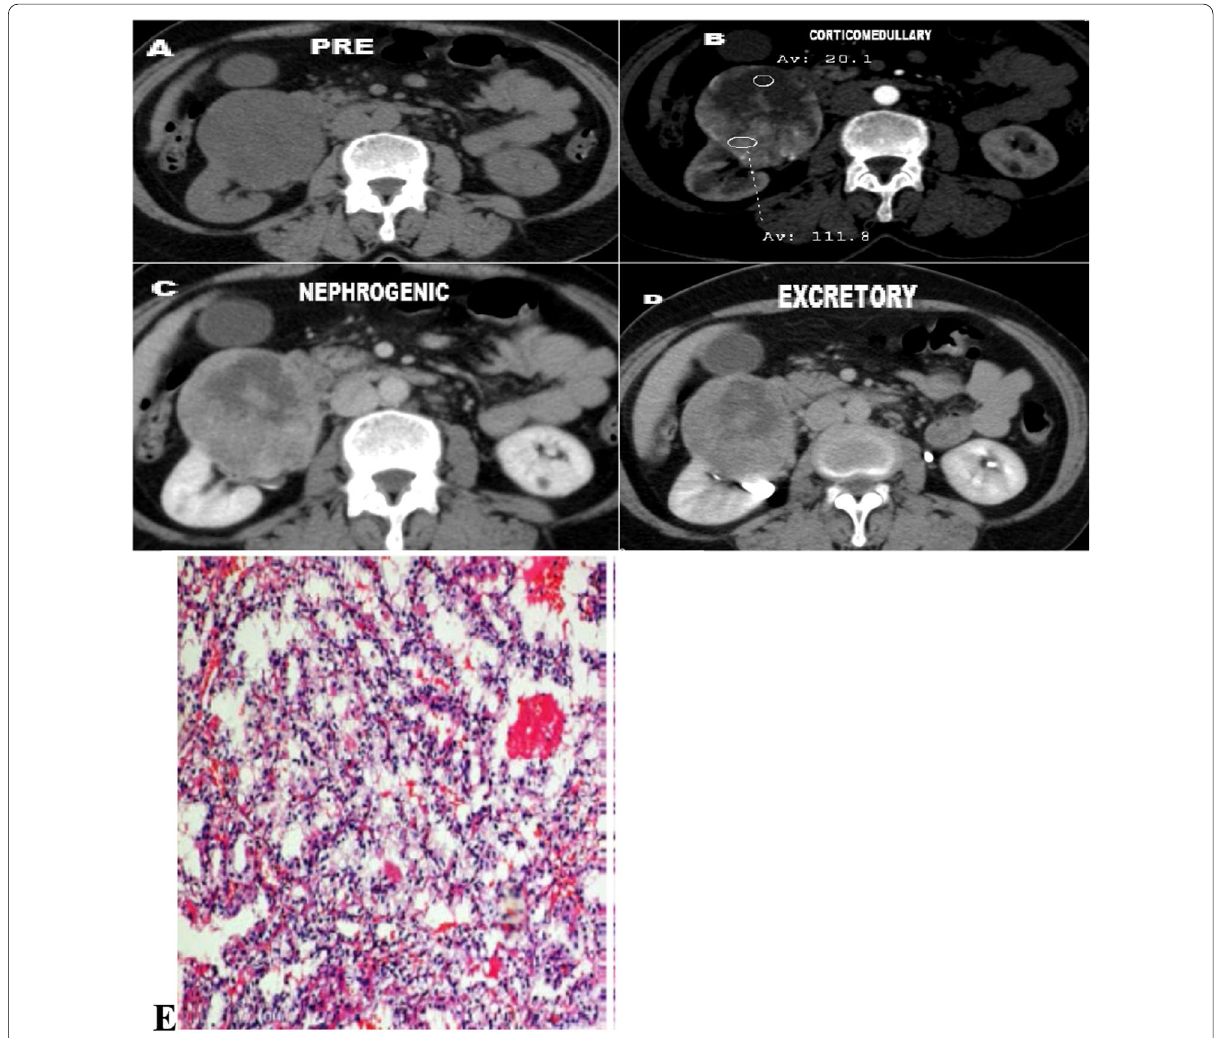
Fig. 3 CCRCC. A 53-year old male patient presented with haematuria. -Pre enhanced scan ( A ) shows right renal large heterogeneous mass, mean attenuation (32 HU) in pre enhanced phase, 151 HU in the corticomedullary phase ( B ).105 HU in the nephrographic phase ( C ). 60 HU in the excretory phase (D). Quantitative findings indicate the high likelihood of the Clear subtypes RCCs. Patient underwent open total nephrectomy. Histopathological diagnosis: High grade Clear cell renal cell carcinoma (Image E